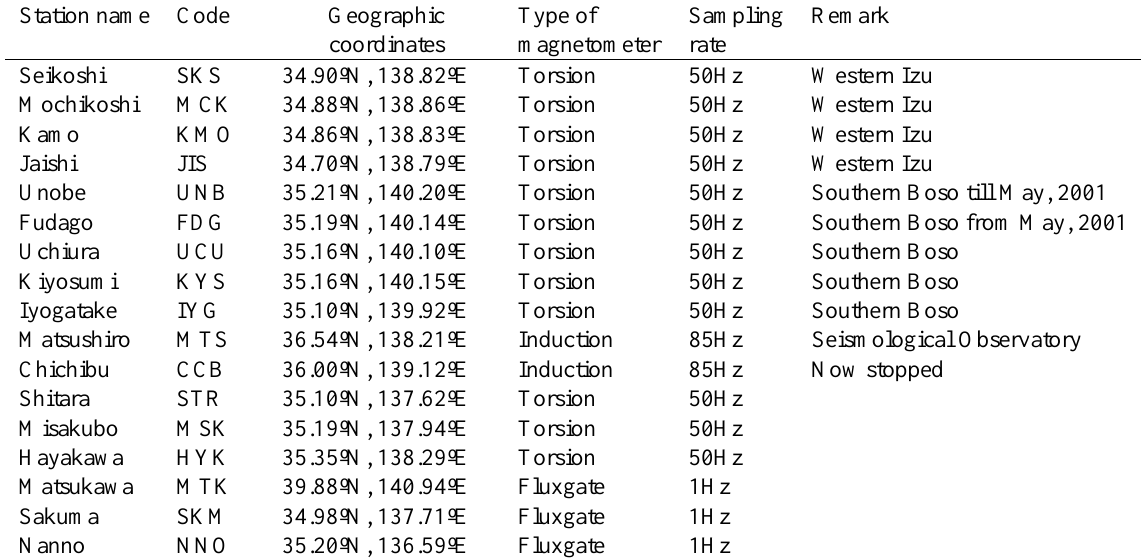
Table 1. List of ULF Stations (May 1,